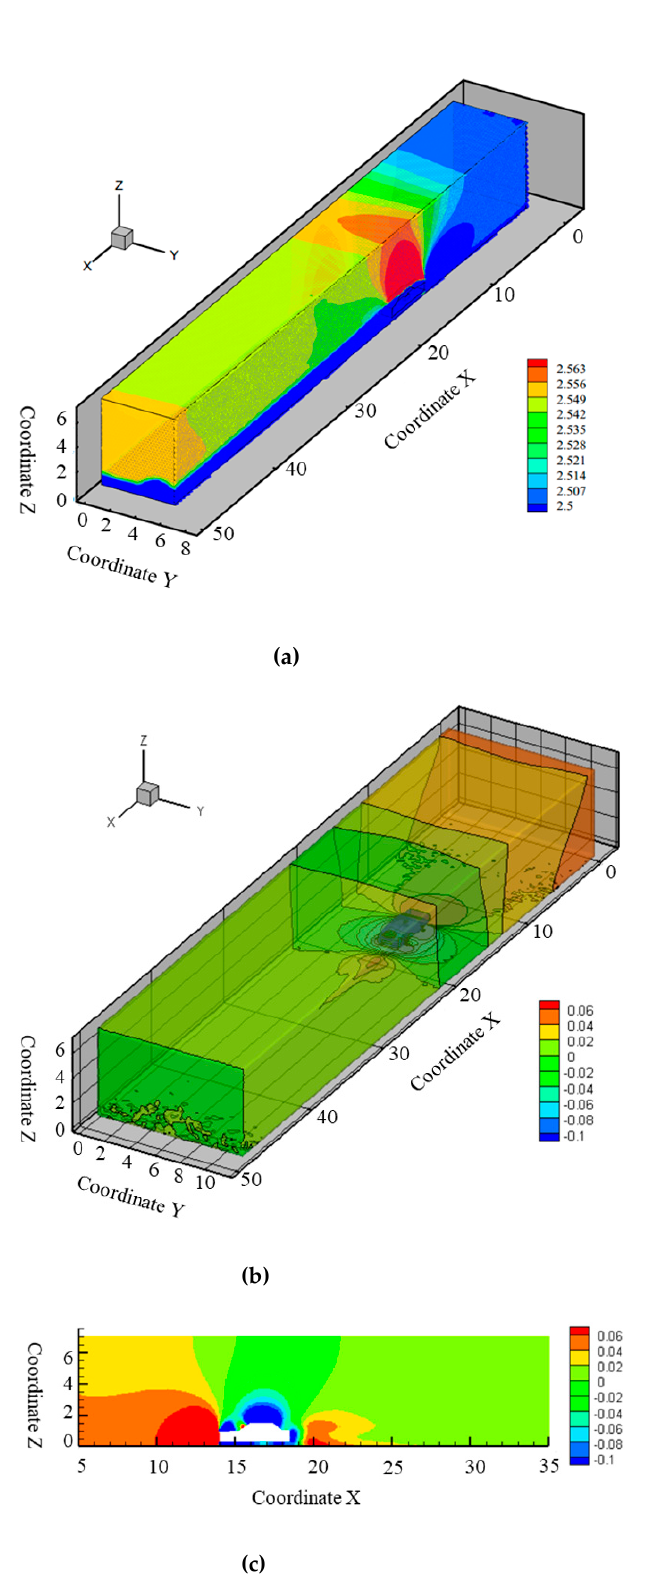
Figure 5. Results of computational fluid dynamics (CFD) simulation and validation. ( a ) Velocity contour of steady-state simulation for a single vehicle; ( b ) Pressure coe ffi cient contour of steady-state simulation for a single vehicle; ( c ) Pressure coe ffi cient contour of the center